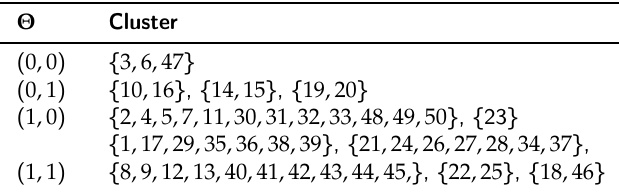
Table 3. Clustering results.